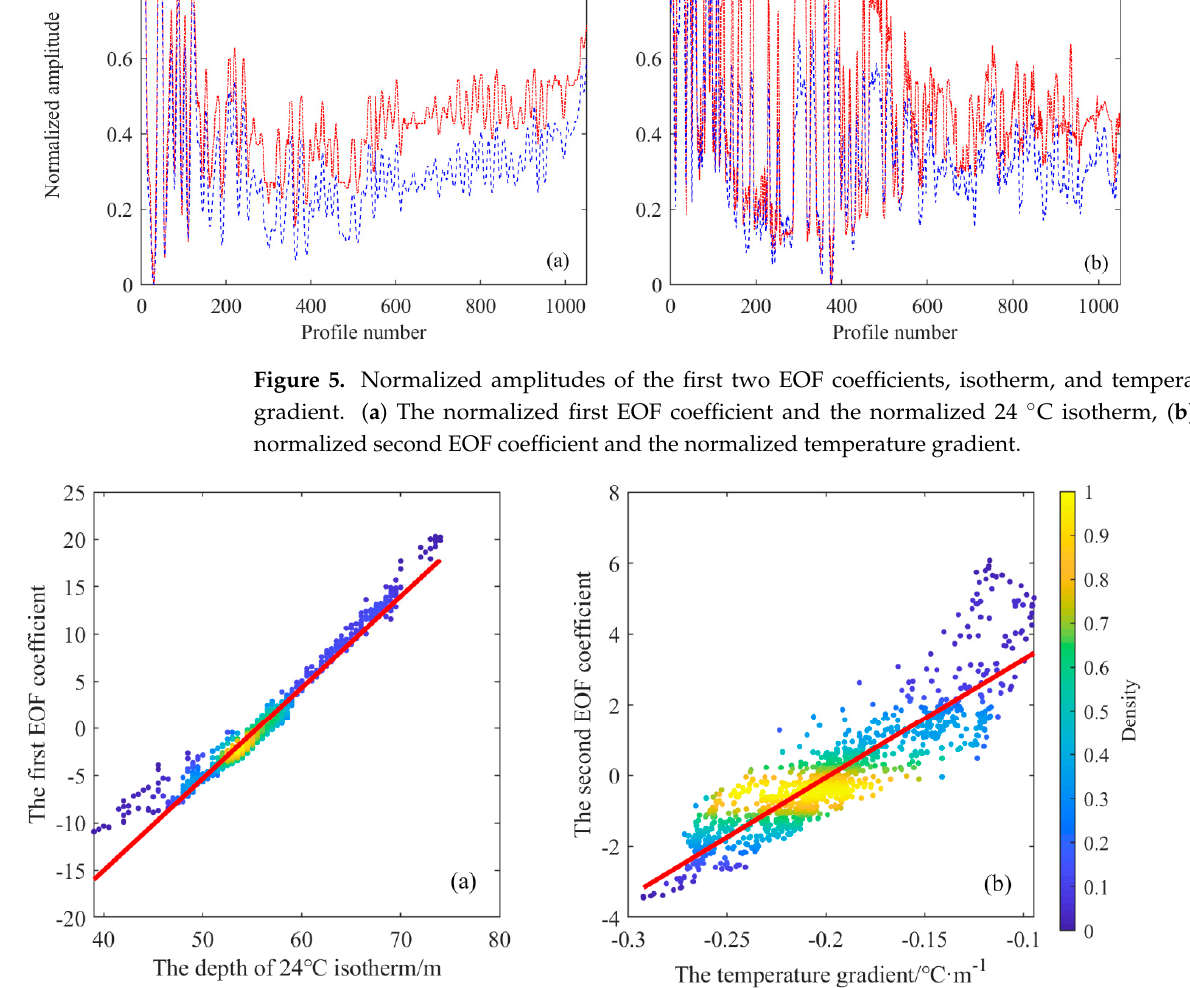
Figure 6. Correlation analysis of the first two EOF coefficients with the isotherm and the tempera- ture gradient. ( a ) The scatter diagram and fitted line of the first EOF coefficient and the 24 ◦ C isotherm, ( b ) the scatter diagram and fitted line of the second EOF coefficient and the temperature gradient.